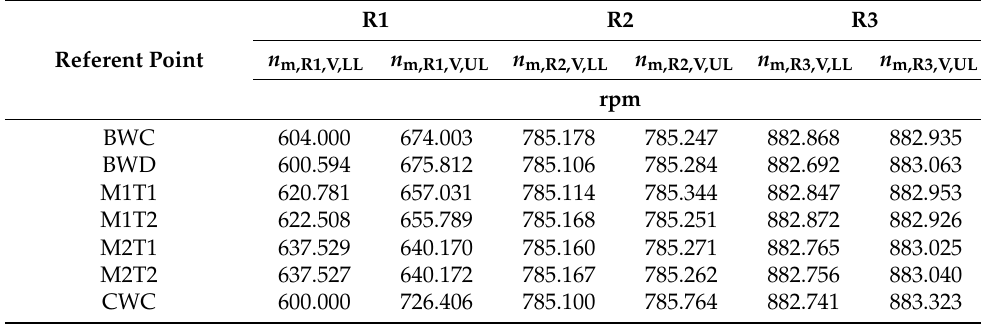
Table 5. Boundaries of the FREM resonant domains according to a V,per –EHO: 1.